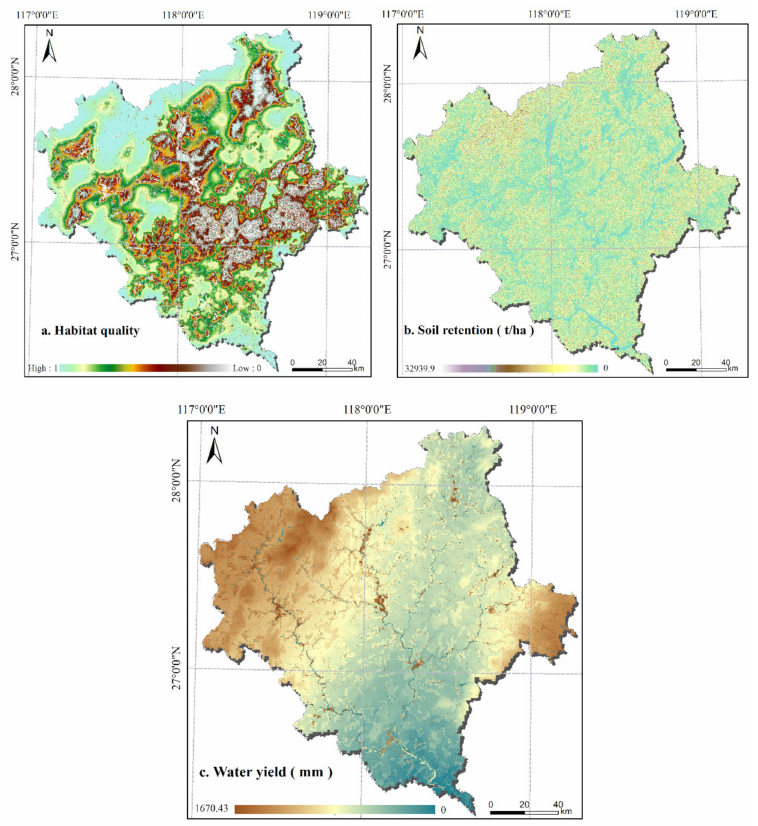
Figure 4. ( a – c ) Spatial distribution of ecosystem services in